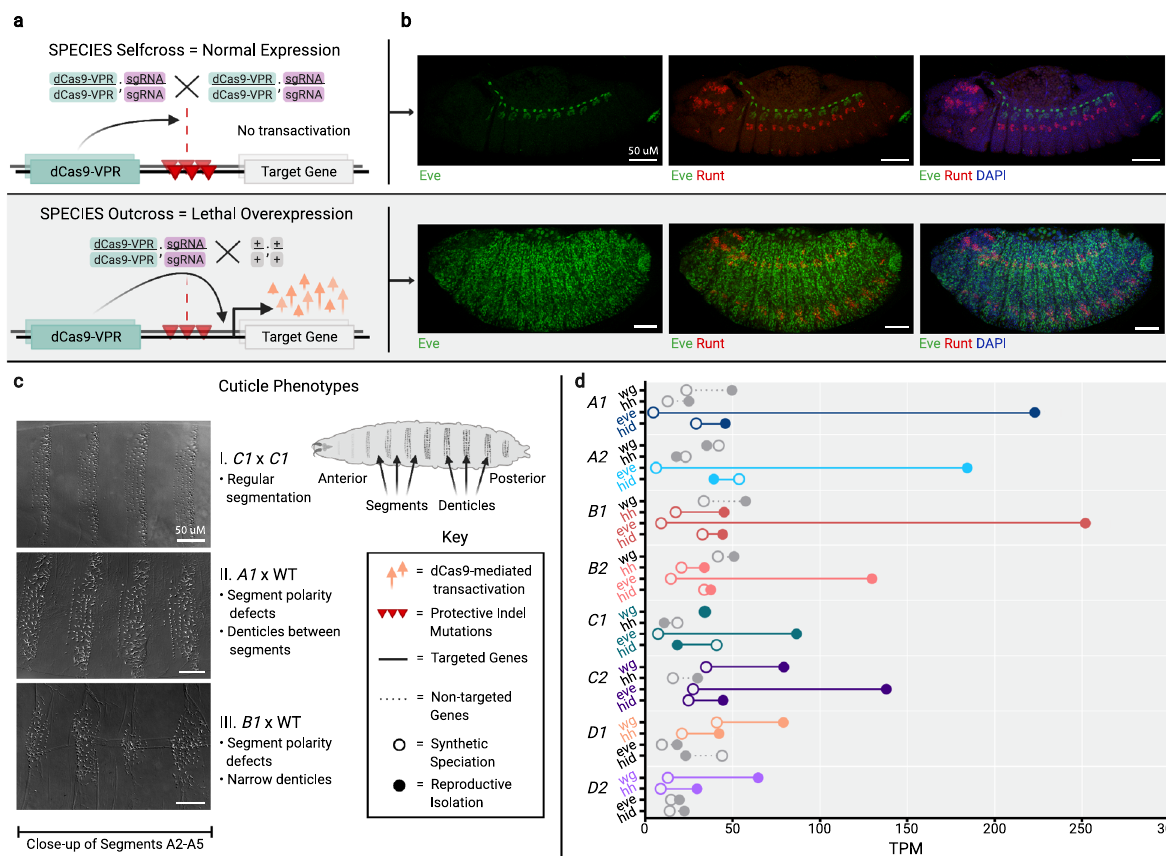
Fig. 3 Visualization and quanti fi cation of target gene overexpression. a Schematic demonstrating reproductive barriers. The homozygous progeny of intercrossed SPECIES contain two copies of protected indel mutations, preventing lethal overexpression. The heterozygous progeny of SPECIES outcrossed to WT inherit only one copy of the protected indel mutations, which cannot prevent lethal overexpression of the target genes. Gray shaded background indicates expected lethality. b Antibody stains for Eve (green) and Runt (red) in stage-13 embryos. DAPI (blue) stains all nuclei. Top row shows A1 × A1 . Bottom row shows A1 × WT SPECIES outcross and Eve overexpression. c Cuticle preparations showing denticle belts in self cross vs. outcross. Representative embryos and larval cuticles shown in Fig. 3b, c. Separate crosses produced animals with similar expression patterns and phenotypes (two crosses per genotype, N > 30 embryos or larval cuticles examined per cross). d Normalized embryo RNA-seq data (transcripts per kilobase million, TPM) for each species either self-crossed (open circles) or outcrossed to WT (closed circles), indicating expected target gene overexpression (colored) (Supplementary Table 2). Source data are provided as a Source Data fi